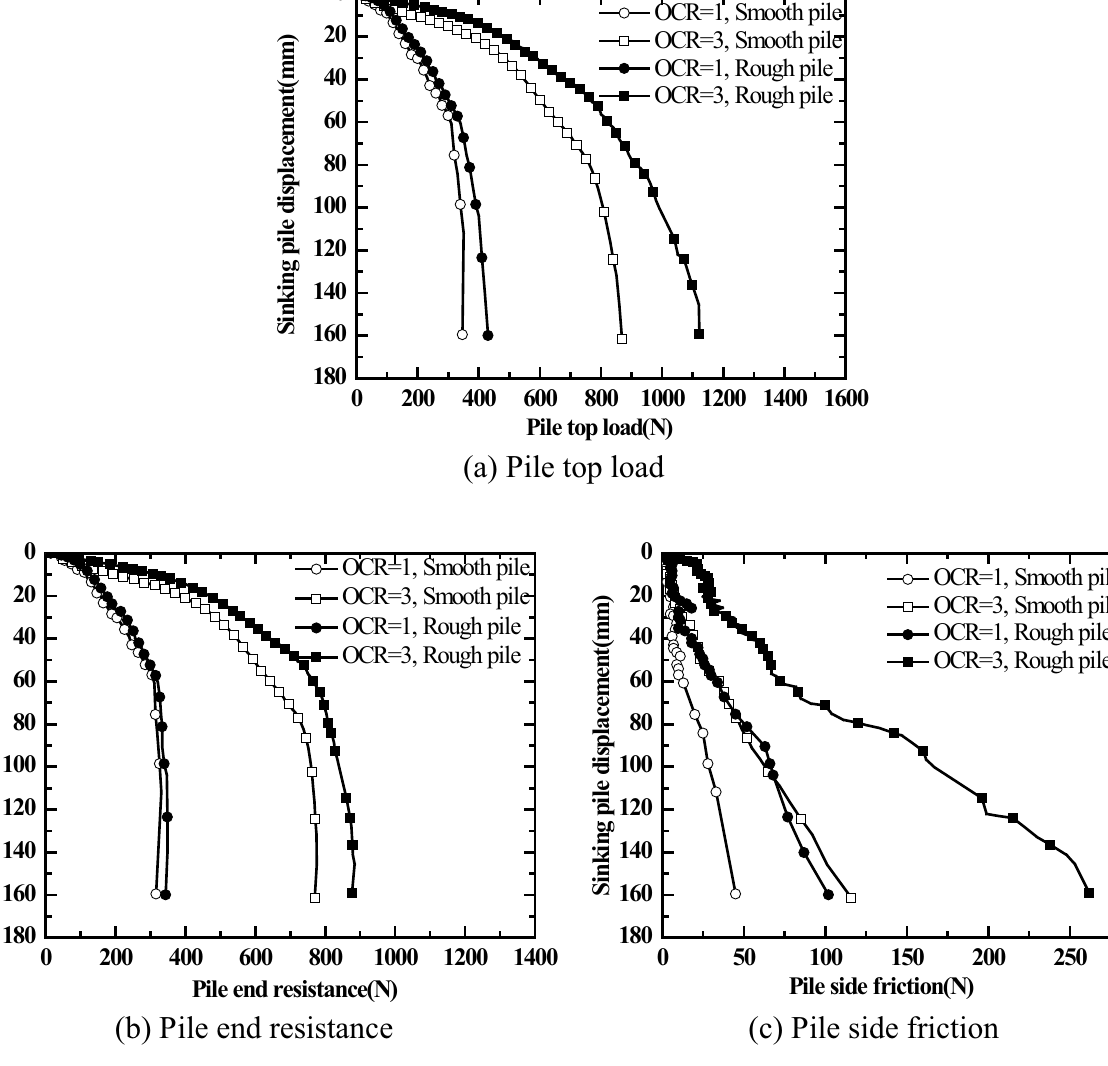
Figure 7. Relation curves for pile top (pile end resistance, pile side friction)—Pile Sinking